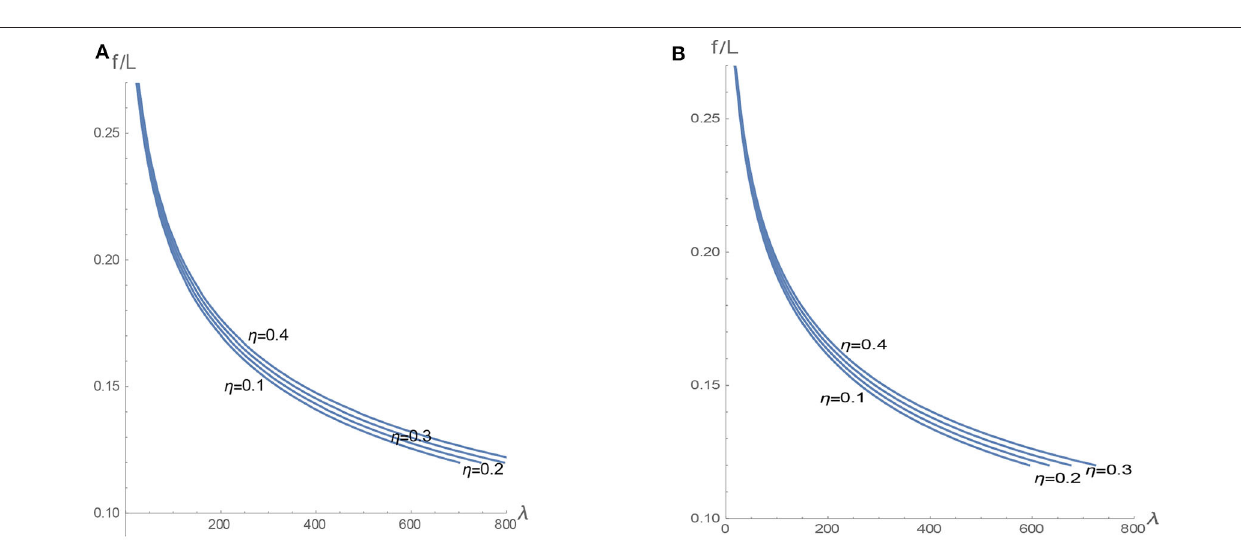
FIGURE 6 | Optimal rise/span ratio f / L versus λ for different values of η and constraints stiffness: (A) k = 0 and (B) k =